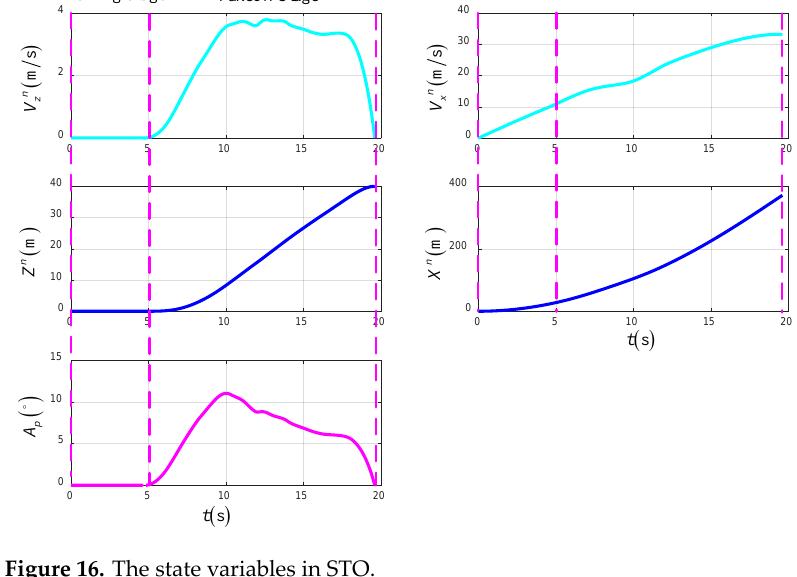
Figure 16. The state variables in STO.